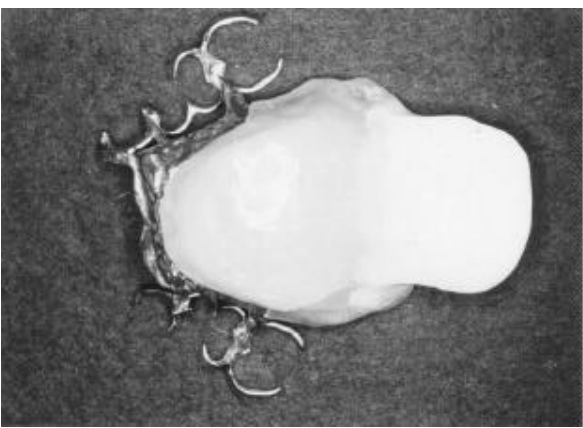
FIGURE 1B AND 1C - Obturador prothesis with speech bulb